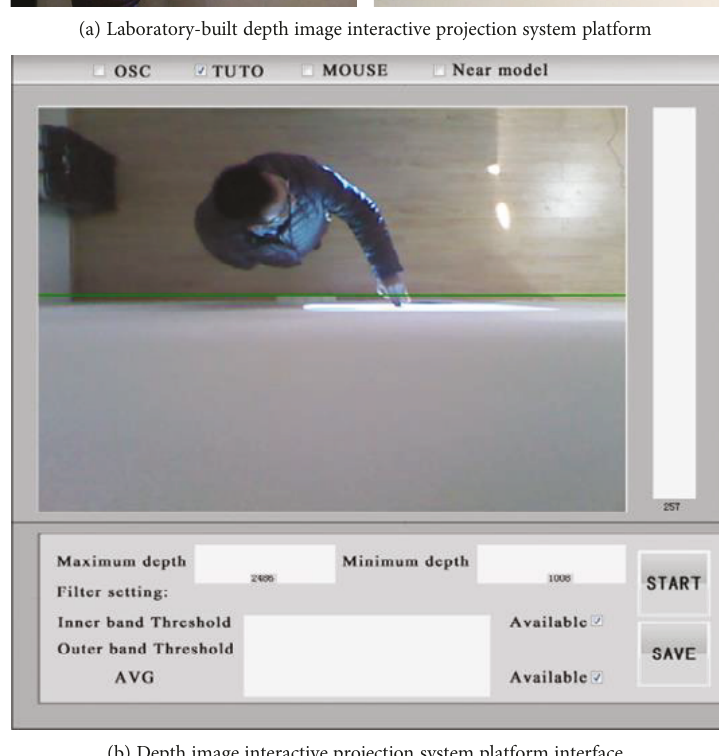
Figure 5: Interactive projection system platform and interface based on depth